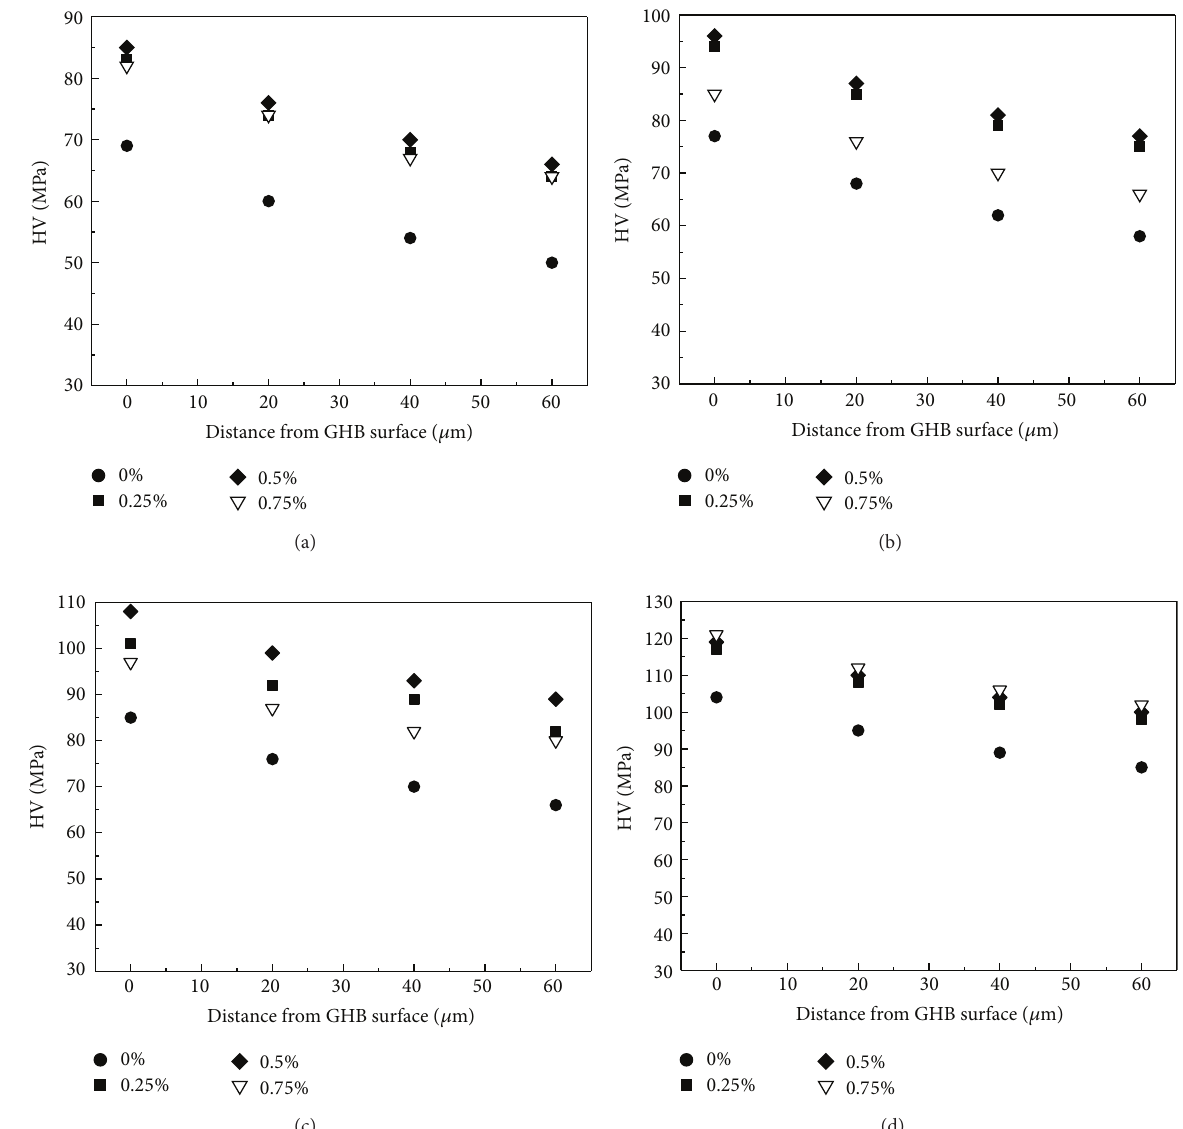
Figure 5: The influence of NS contents on the interfacial HV of lightweight aggregate concrete: (a) 7 d of water curing, (b) 14d of water curing, (c) 28 d of water curing, and (d) 56 d of water